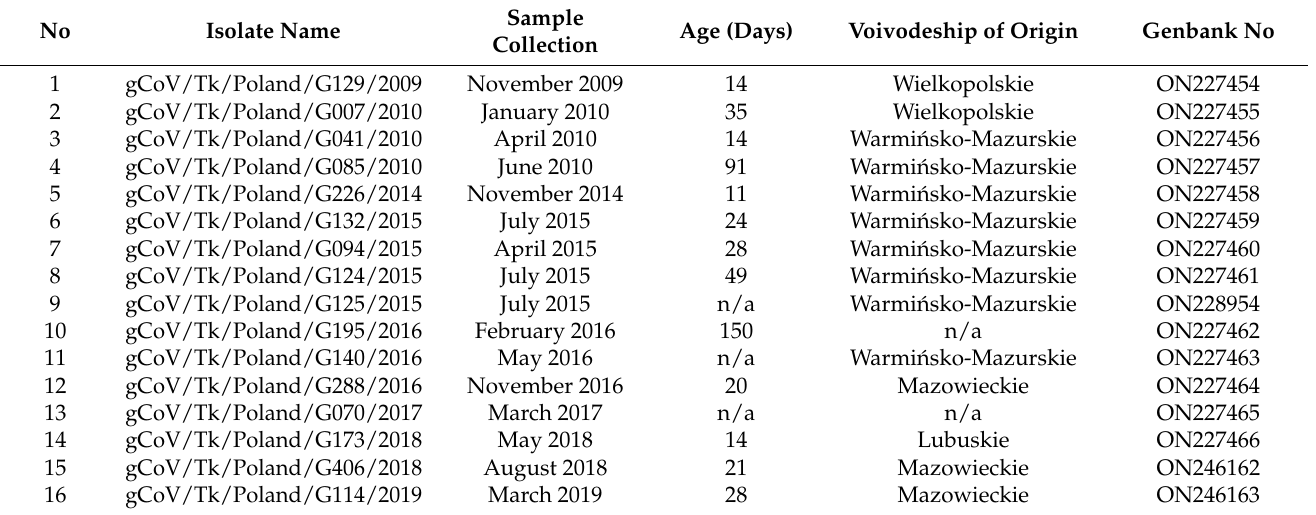
Table 2. Sample information for TCoV sequences included in the phylogenetic